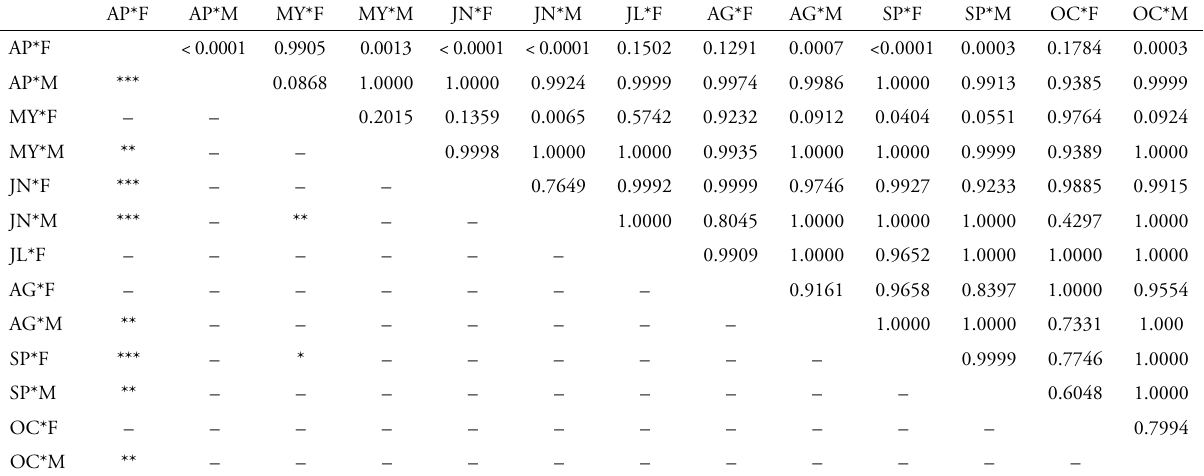
Table 2. Urobopyrus processae . Tukey-Kramer post hoc interactions of Least Square Means for effect of sample*gender on parasite total length (TL, in mm) in 2011. F = female, M = male, AP = April, AG = August, JN = June, MY = May, OC = October, SP = September, P > 0.05 = -, P < 0.05 = *, P < 0.01 = **, P < 0.001 =